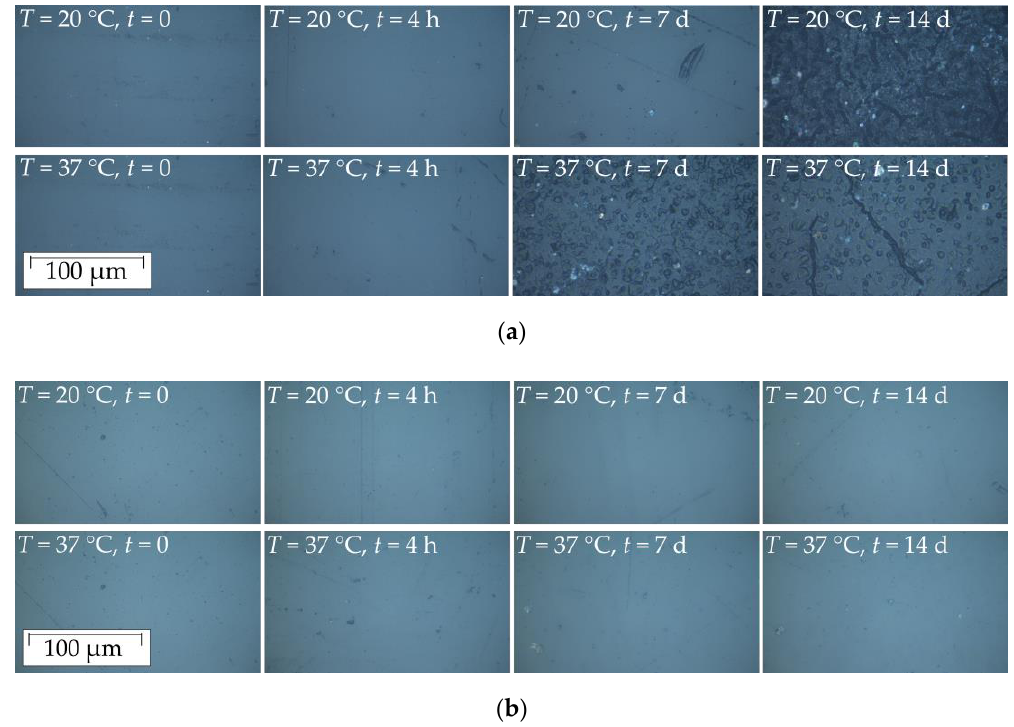
Figure 8. Microscopic images (magnification M = 100) illustrating the alteration of selected polymer surfaces stored in NaOCl solution at different temperatures after different storage times: ( a ) PA6 samples; ( b ) PEEK